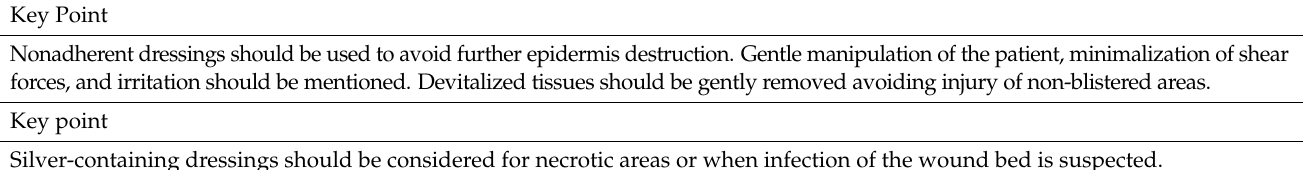
Table 4. Key points for wound